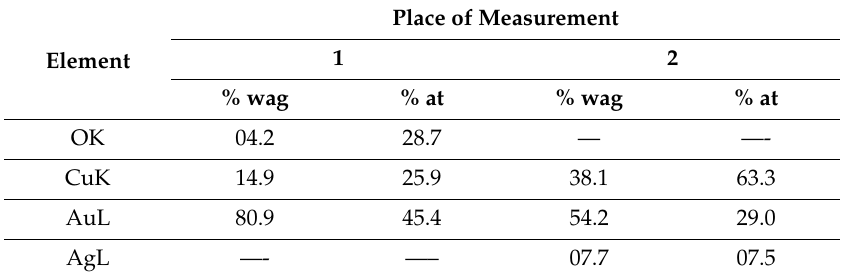
Figure 3. Dependence of the ozone concentration on the working time of electrodes.